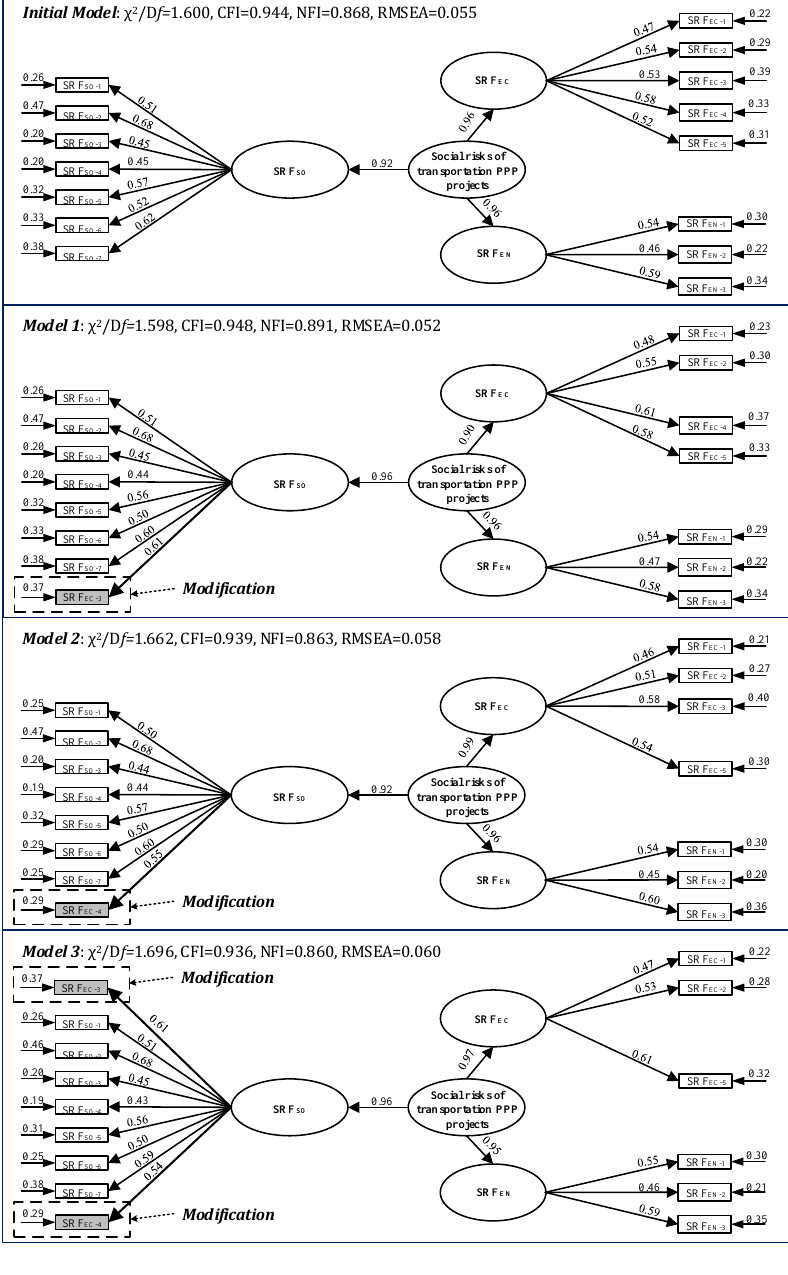
Figure 5. The estimations of proposed models by CFA.